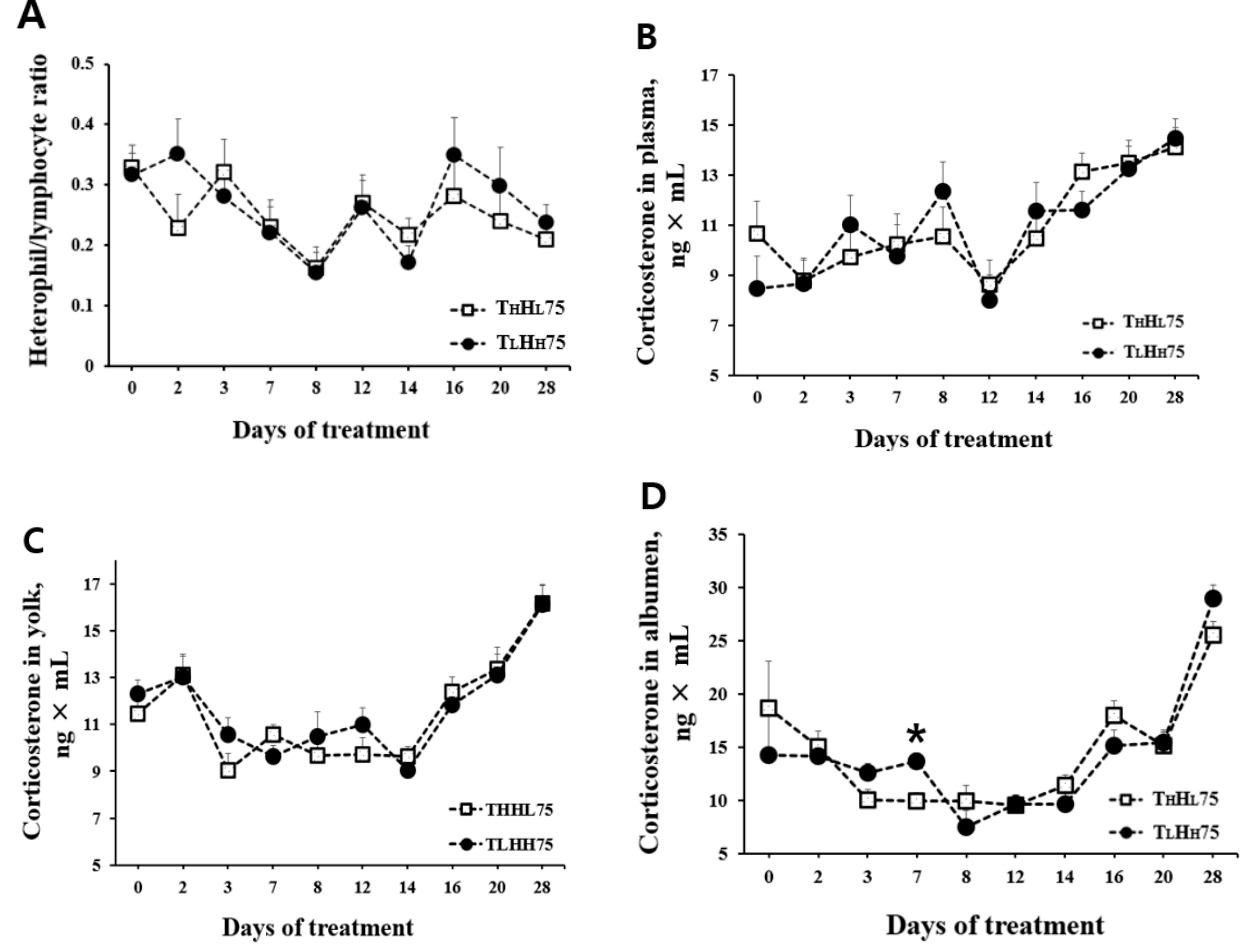
Figure 3. Effect of different ambient temperatures and humidity (same temperature-humidity index) on het- erophil/lymphocyte ratio in blood, and corticosterone in plasma, yolk, and in albumen. T L H H 75 = temperature 26 ◦ C; relative humidity 70%; T H H L 75 = temperature 30 ◦ C; relative humidity 30%. The asterisk indicates a significant difference between the means. Error bars indicate the standard deviation of the mean ( n = 10). ( A ) Heterophil/lymphocyte ratio. ( B ) Corticosterone in plasma (ng × mL). ( C ) Corticosterone in yolk (ng × mL). ( D ) Corticosterone in albumen (ng × mL).